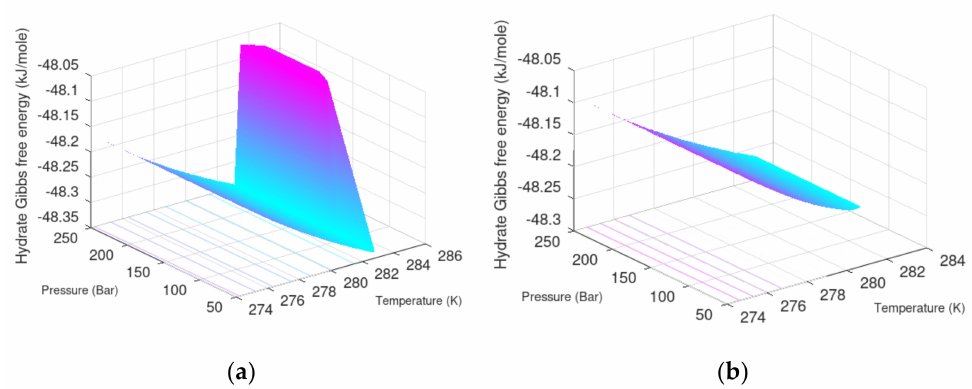
Figure 2. Gibbs free energy for hydrates formed homogeneously from water and dissolved CO 2 in water: ( a ) pure water and ( b ) NaCl mole-fraction in water 0.0384.